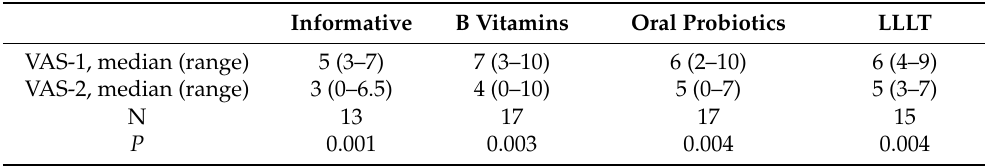
Table 7. Differences between VAS-1 and VAS-2 scores in BMS patients with different types of therapy (Wilcoxon signed-rank